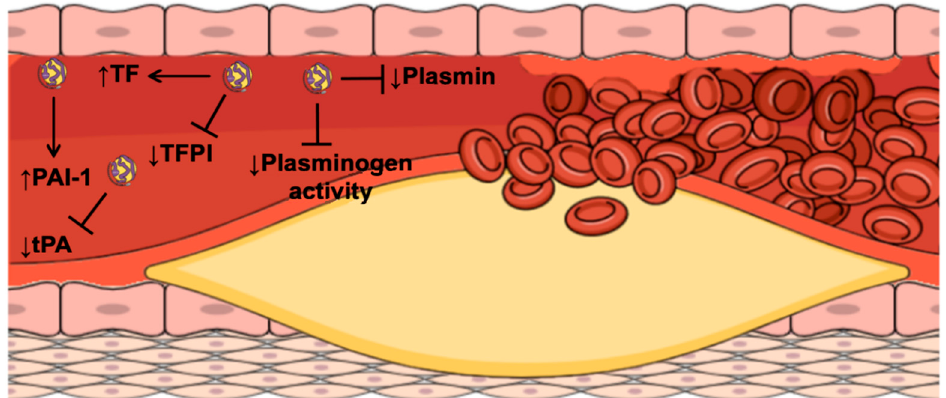
Figure 3. The role of Lp(a) in thrombus formation following plaque rupture. TF, tissue factor; TFPI, tissue factor pathway inhibitor; PAI-1, plasminogen activator inhibitor-1; tPA, tissue plasminogen activator.